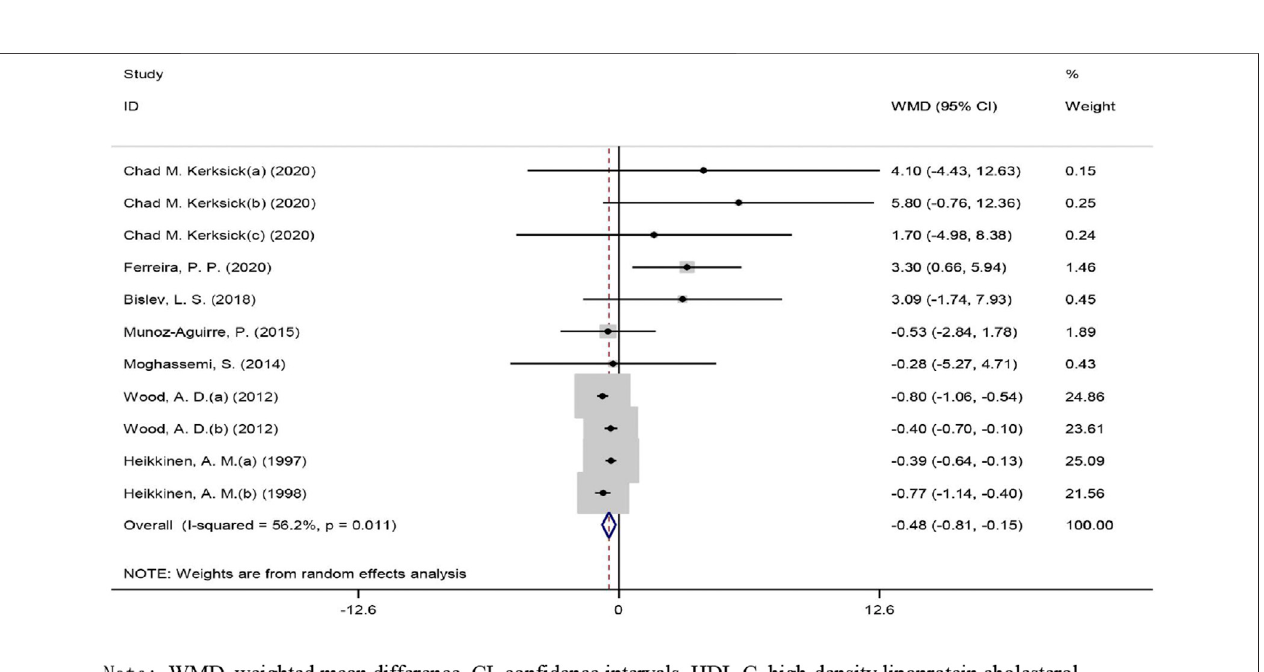
Frontiers in Molecular Biosciences |